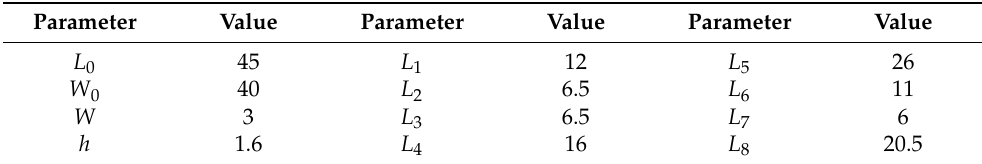
Figure 1. Geometrical design of the proposed antenna. ( a ) Top view. ( b ) Side view. ( c ) Bottom view. Table 2. Dimensions of the proposed antenna (all values are in mm).